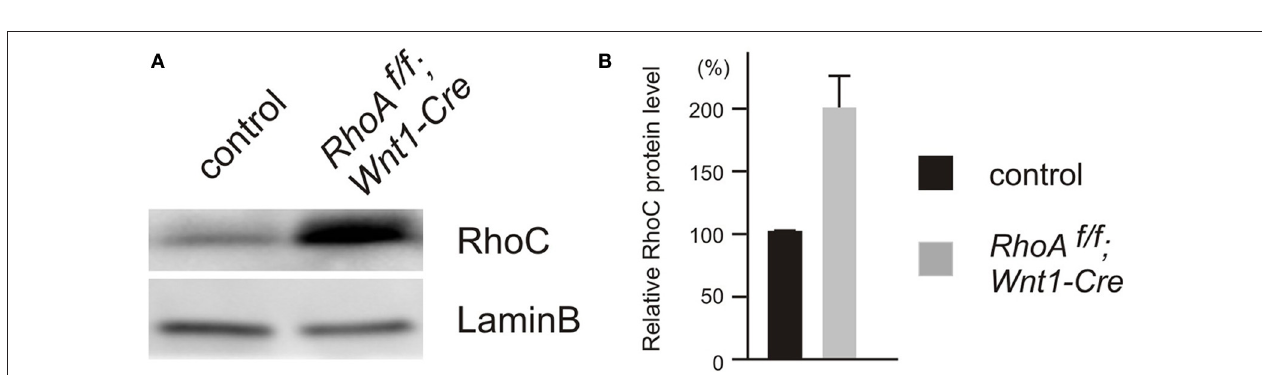
FIGURE 7 | Sema3A-induced DRG axonal repulsion in vitro . (A–D) Co-culture of DRG explants from control and RhoA f / f ; Wnt1-Cre embryos with GFP (A,C) , or Sema3A and GFP (B,D) transfected cell aggregates. The